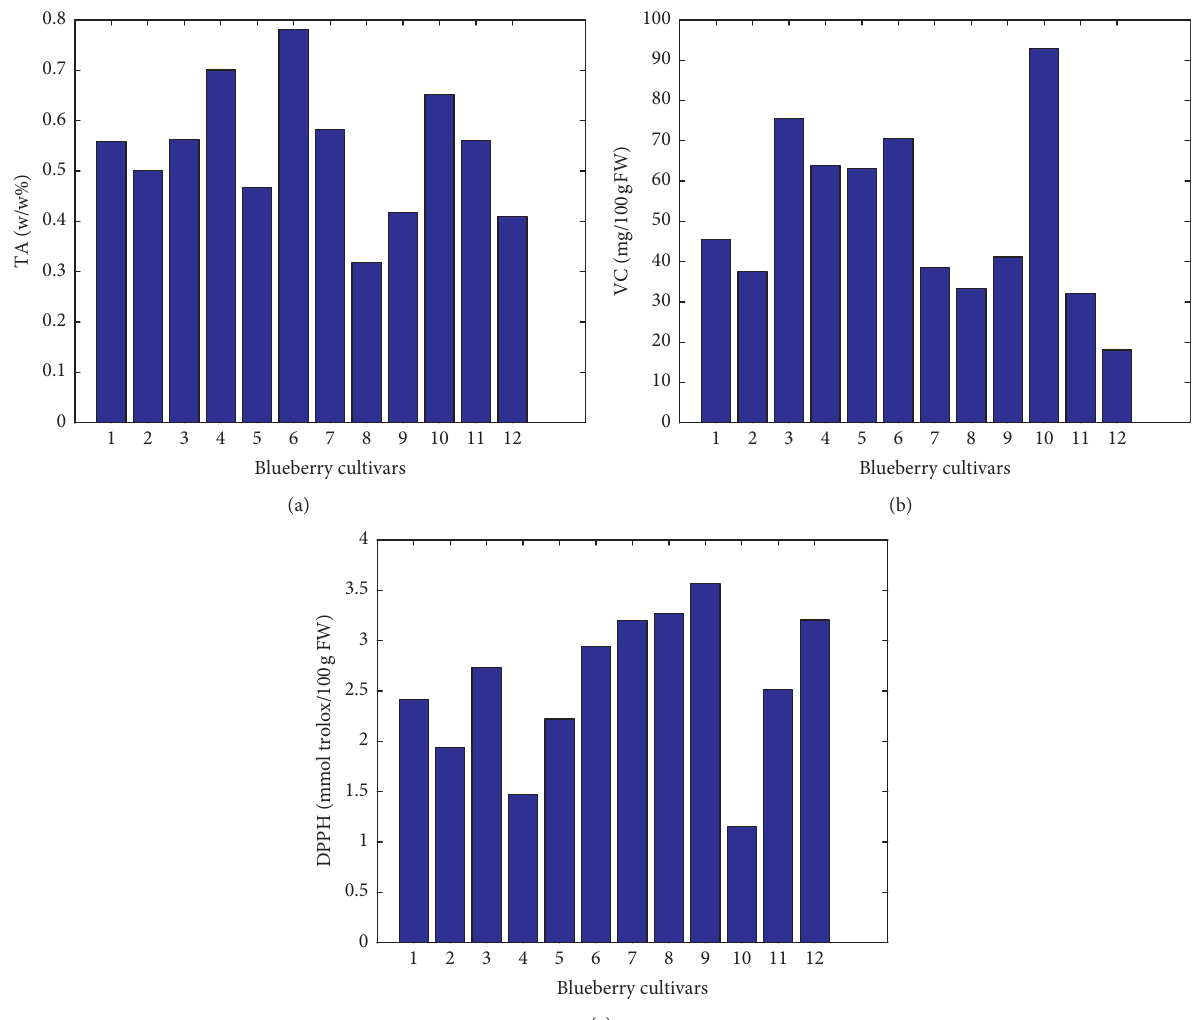
Figure 3: Averages of the 4 factors having the highest CV values over the 12